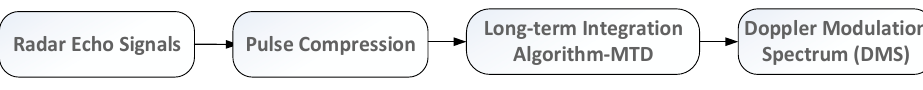
Figure 5. The specific process of obtaining the DMS.